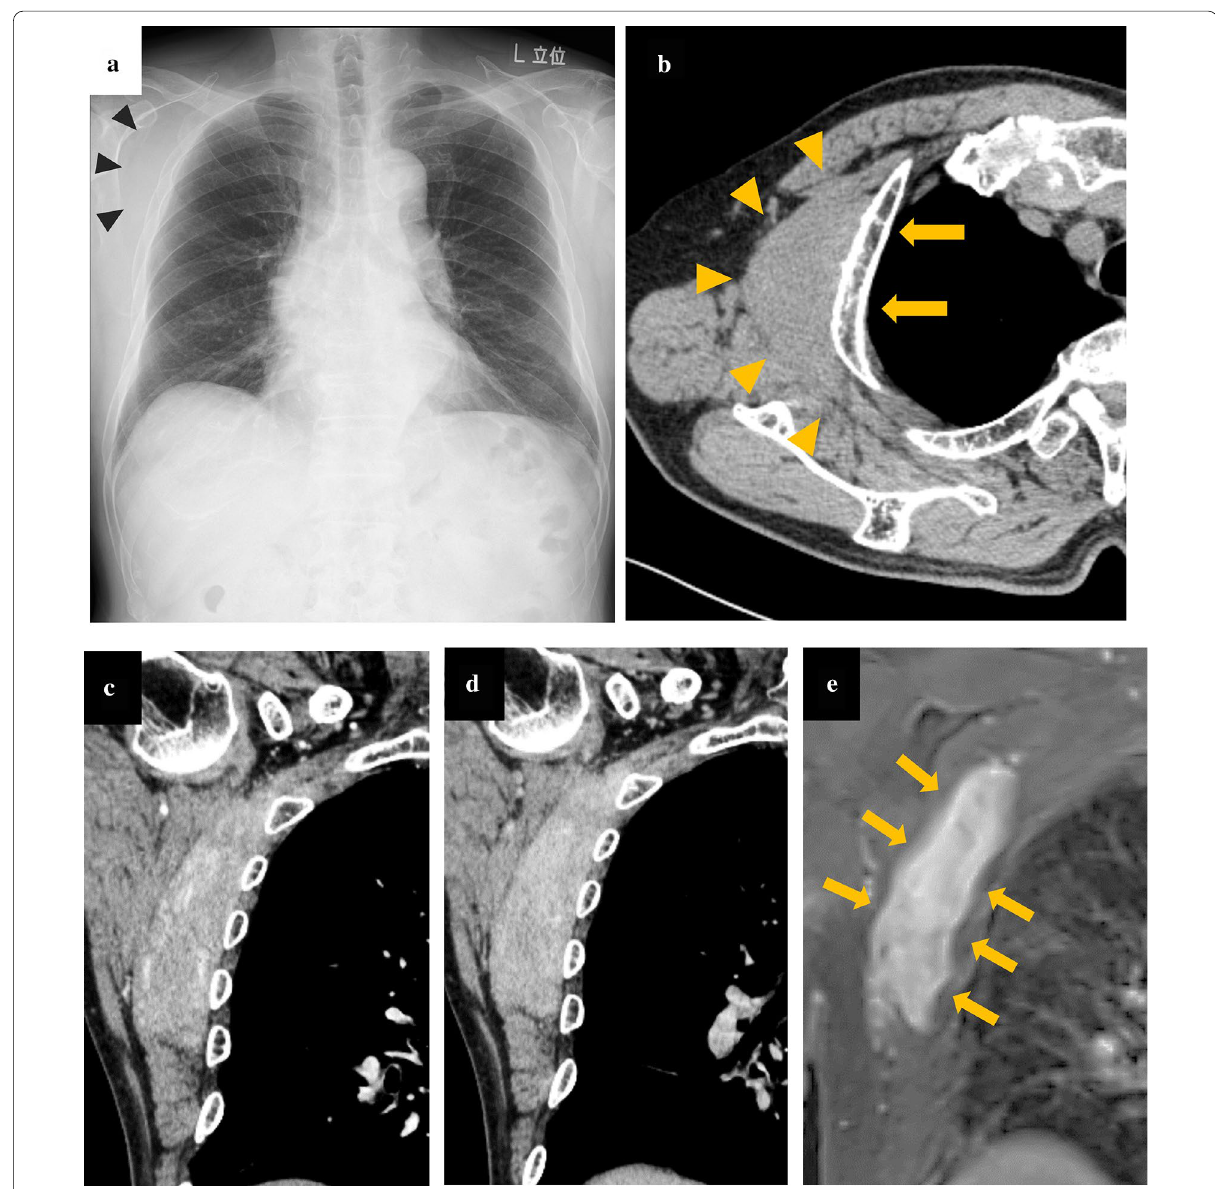
Fig. 1 Radiological imaging of a case of desmoplastic fibroblastoma in the chest wall. a Chest radiograph demonstrating soft tissue thickening at the right lateral upper chest wall (arrowhead). b Axial view of a non-contrast computed tomography (CT) scan demonstrating the location of the tumor (arrowhead) and cortical bone erosion of the second rib (arrow). c , d Coronal view of a dynamic contrast-enhanced CT scan demonstrating the line of abundant vascularity at the periphery of the tumor during the early phase ( c ) and homogeneous enhancement during the delayed phase ( d ). e Coronal view of gadolinium-enhanced T1-weighted magnetic resonance imaging (MRI) with fat suppression, demonstrating inhomogeneous enhancement in the tumor, as well as rim-like contrast enhancement with uniform thickness at the tumor periphery